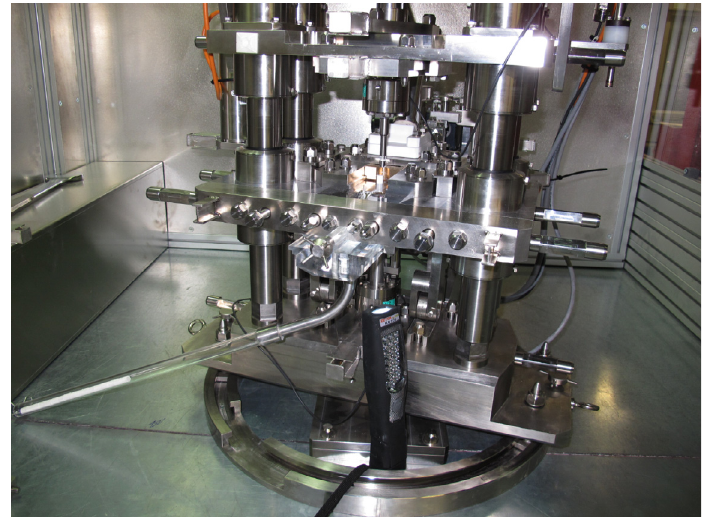
Fig. 2. Press in the mock-up, with conveyor and tubular container of 37